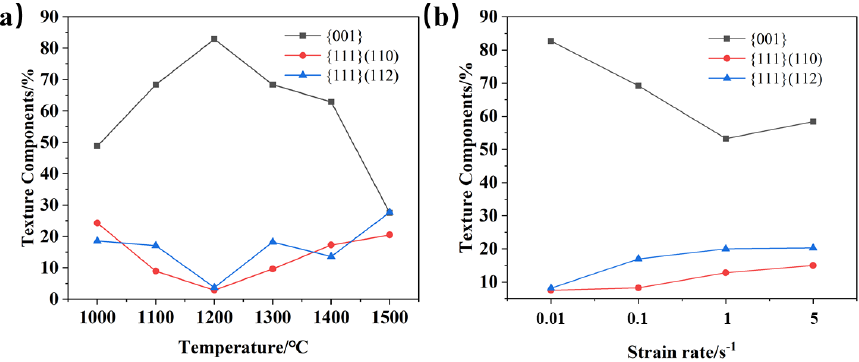
Figure 19. Variation trend of texture composition under different conditions: ( a ) 0.01 s −1 , ( b ) 1200 °C.